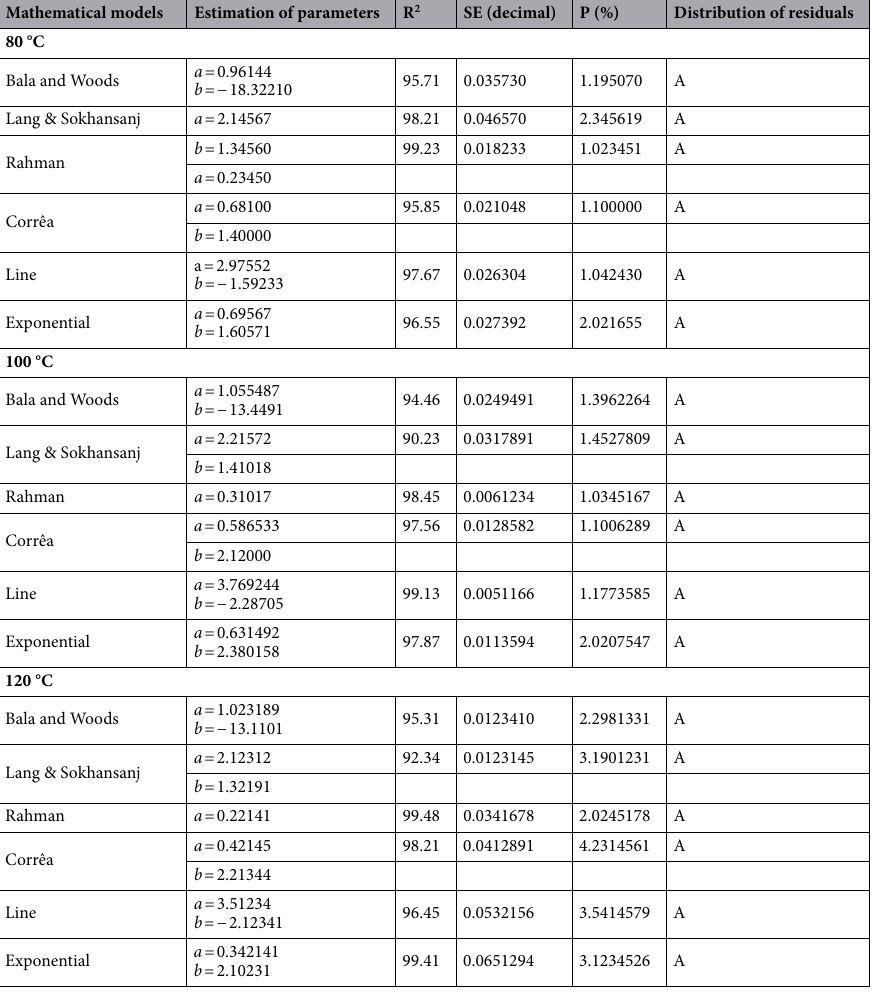
Table 6. Parameters estimated, coefficient of determination (R 2 ), estimated average (SE) and relative error (P) and distribution of residues of the mathematical models used to describe the shrinkage of soybeans grains to different drying air temperatures and an initial moisture content of the grains of 18%